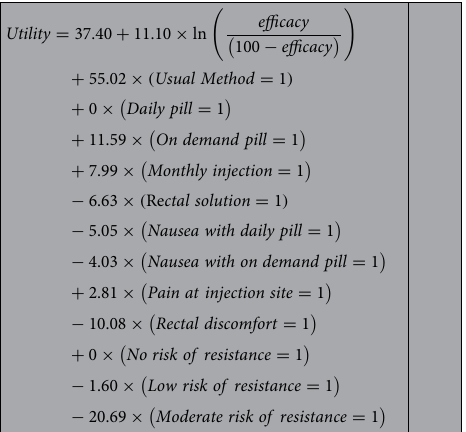
Box 1. Formula for calculating utility scores on a scale from 0 (least preferred combination of attributes) to 100 (most preferred combination of attributes) a . a Efficacy = 50% for least preferred combination and 99% for most preferred. The formula calculates point estimates for individual utility scores based on results of the mixed logit model.